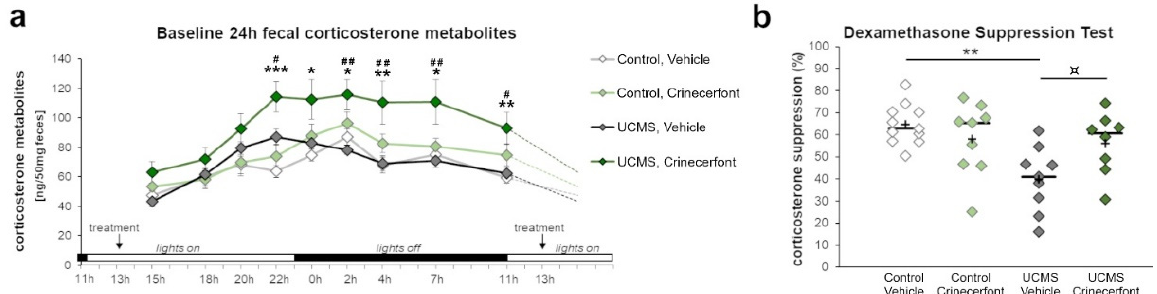
Figure 2. The CRF-R1 antagonist crinecerfont treatment increased circadian fecal corticosterone levels and preserved HPA axis negative feedback under chronic stress. The baseline circadian activity of the HPA axis (panel a ) and the dexamethasone suppression test (panel b ) were assessed using the levels of fecal corticosterone metabolites. ( a ) The 5-week crinecerfont treatment (20 mg · kg − 1 · day − 1 , ip) exacerbated the level of corticosterone metabolites at six out of nine time points over a day, uniquely in mice exposed to the unpredictable chronic mild stress (UCMS). n = 8–11 per group; * p < 0.05, ** p < 0.01, and *** p < 0.001 UCMS-crinecerfont vs. control-vehicle mice; # p < 0.05 and ## p < 0.01 UCMS-crinecerfont vs. UCMS-vehicle mice. Data represent mean ± sem. ( b ) The dexamethasone suppression test allowed assessing the integrity of the HPA axis negative feedback. UCMS significantly decreased the ability of corticosterone suppression in vehicle mice, an effect that tended to be cancelled with crinecerfont treatment. n = 8–11 per group; ¤ p < 0.10 and ** p < 0.01 between line-connected groups. Scatterplot represents individual results, with the ‘+’ symbol showing the mean and the bar representing the